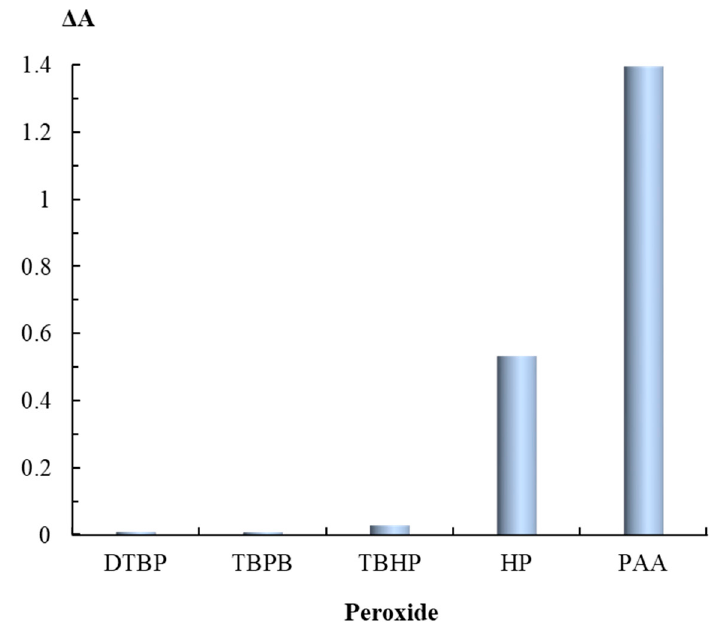
Figure 3. Change in the absorbance of AgTNPs solutions depending on the nature of a peroxide. c (AgTNPs) = 0.16 mM Ag, c (peroxide) = 0.1 mM, pH 6, t = 10 min.